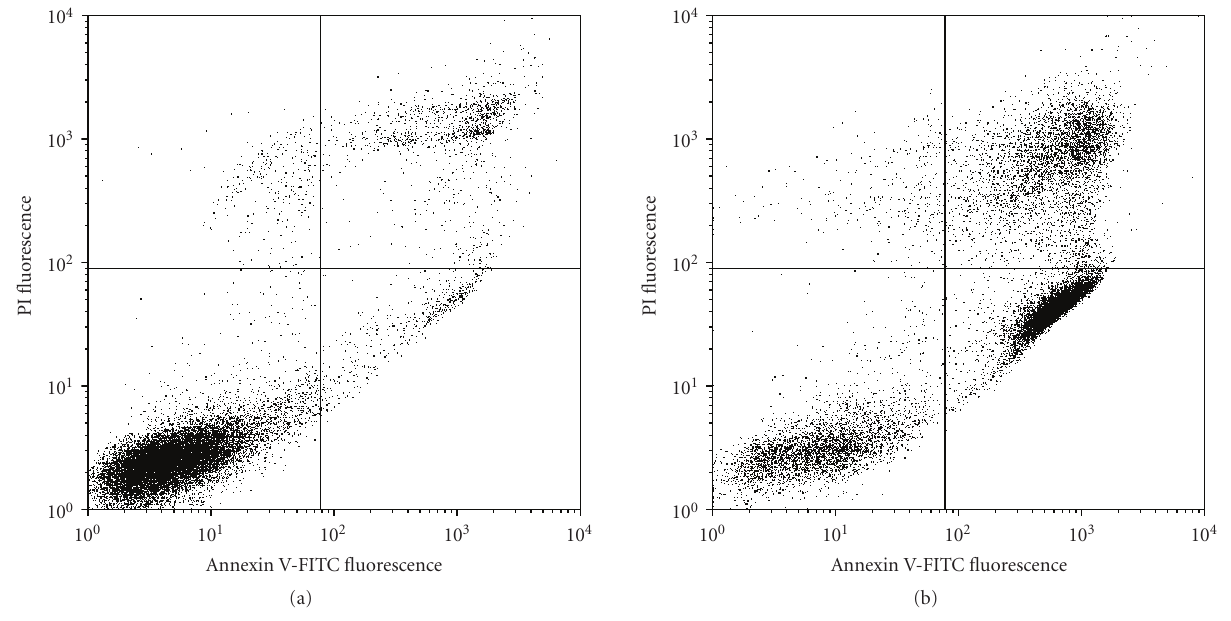
Figure 3: Representative flow cytometric histograms of apoptotic Jurkat T-cells stained with annexin V-FITC and propidium iodide (PI). Jurkat T-cells (2 × 10 6 /mL) were left untreated or treated with camptothecin (CPT, 8 μ M) at 37 ◦ C for 24 h, followed by staining with ANV- FITC and PI. Apoptotic cells were identified as ANV + PI − and live cells as ANV − PI − on an FACScan analyser.